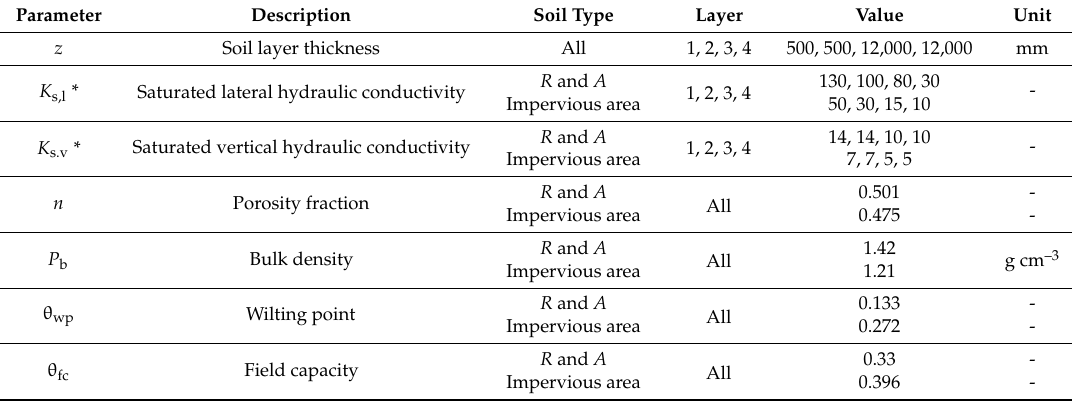
Table 2. Soil parameters for the base model (* = calibrated; all other values from McKane et al. [32]). R stands for Rossmoyne and A stands for Avonburg soil